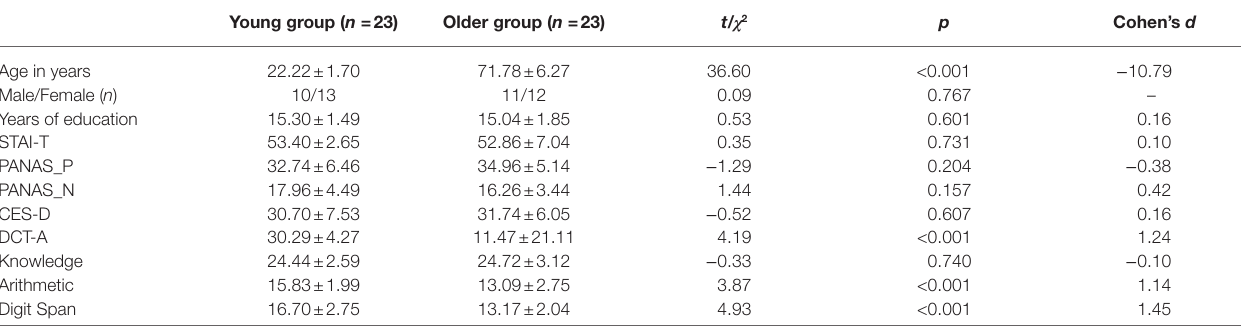
TABLE 1 | Demographic characteristics and neuropsychological measures ( M + SD